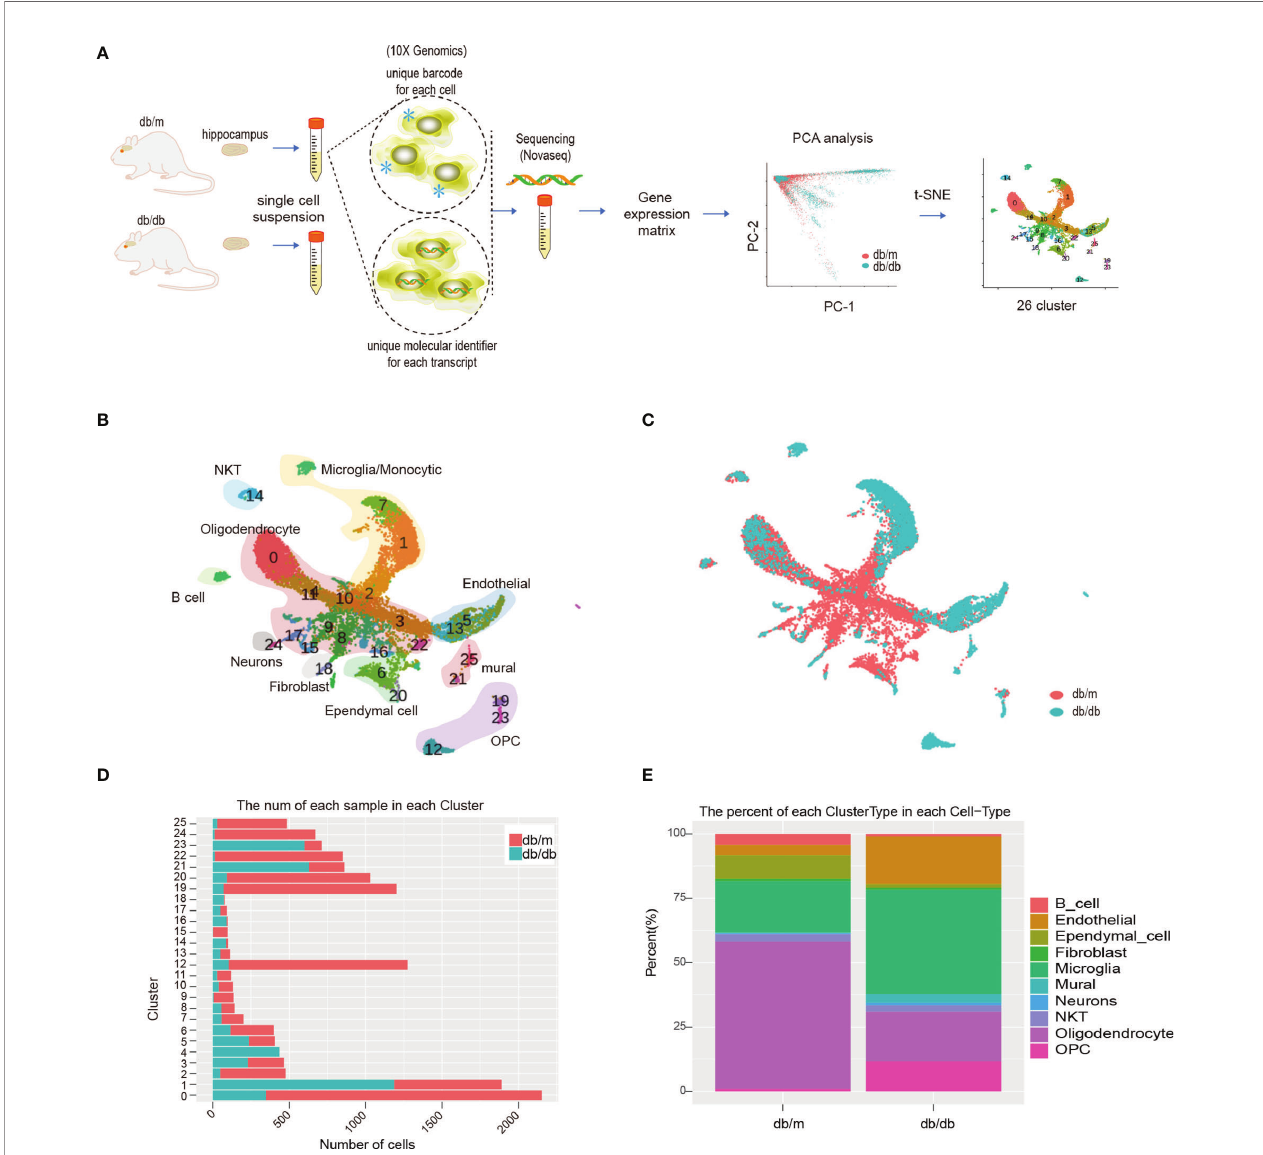
FIGURE 2 | Schematic diagram of the experimental work fl ow, and scRNA-seq analysis of db/db vs db/m mouse hippocampus. The work fl ow is illustrated in (A) , * represent barcode sequence labeled cells. (B) t-SNE plot of 14621 cells isolated from db/db and db/m hippocampus, exhibiting 26 clusters that were identi fi ed. (C) t-SNE plot of 14621 cells isolated from the db/db and db/m hippocampus, colour coded according to genotype. (D) Number of db/db (orange) and db/m (cyan) hippocampus cells per cluster. (E) Relative abundances of the different hippocampus cell types per